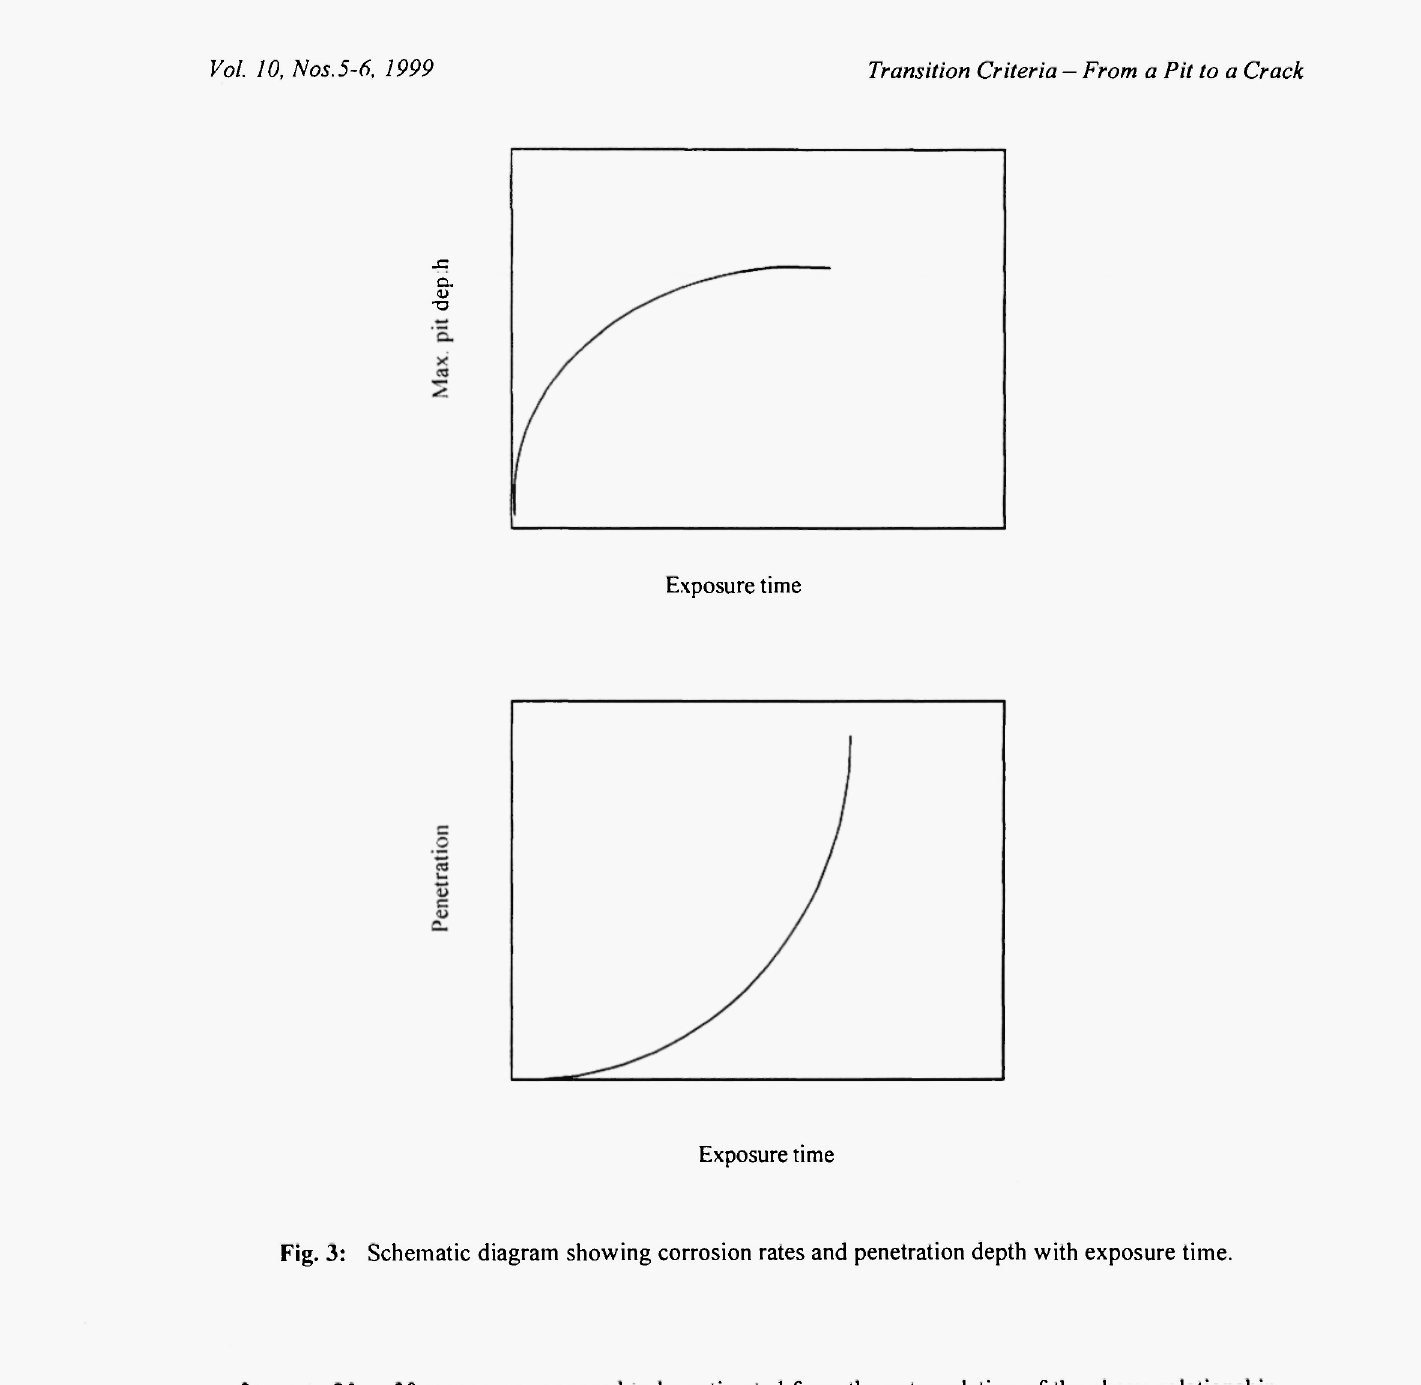
Fig. 3: Schematic diagram showing corrosion rates and penetration depth with exposure